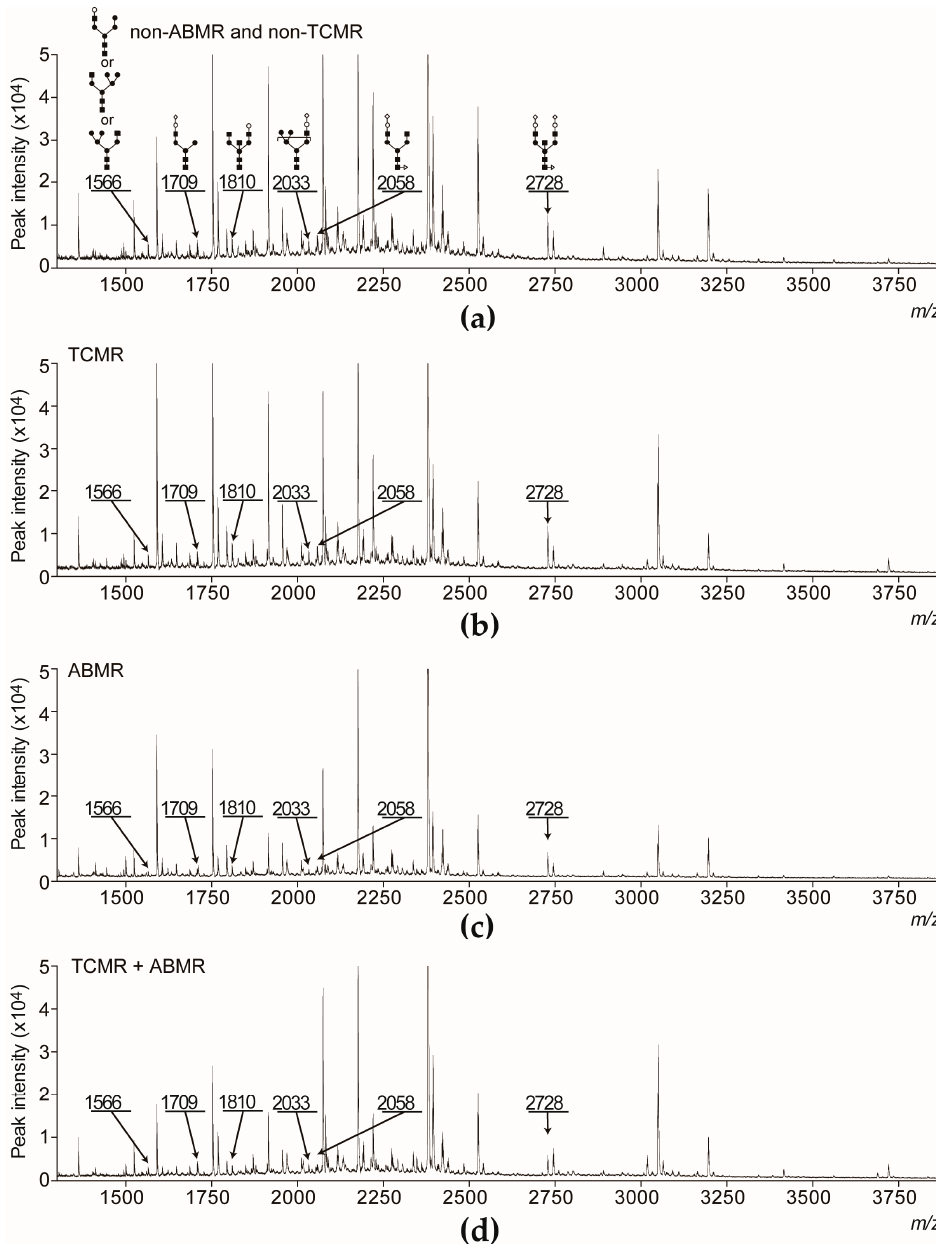
Figure 2. Representative MALDI-TOF mass spectra ( m / z range of 1250 to 3865) of benzyloxyamine (BOA)-labeled N -glycans derived from the serum of patients one day before LKTx without ABMR (non-ABMR; no adverse events and TCMR alone) and with ABMR (with or without TCMR). ( a ) A mass spectrum of serum N -glycans from a patient who did not develop any adverse events; ( b ) A mass spectrum of serum N -glycans from a patient who developed TCMR; ( c ) A mass spectrum of serum N -glycans from a patient who developed ABMR; ( d ) A mass spectrum of serum N -glycans from a patient who developed ABMR and TCMR. The peaks of ABMR-related N -glycans ( m / z 1566, 1709, 1810, 2033, 2058, and 2728) are indicated in the mass spectra. The putative structures of m / z 1566, 1709, 1810, 2033, 2058, and 2728 are indicated by monosaccharide symbols.